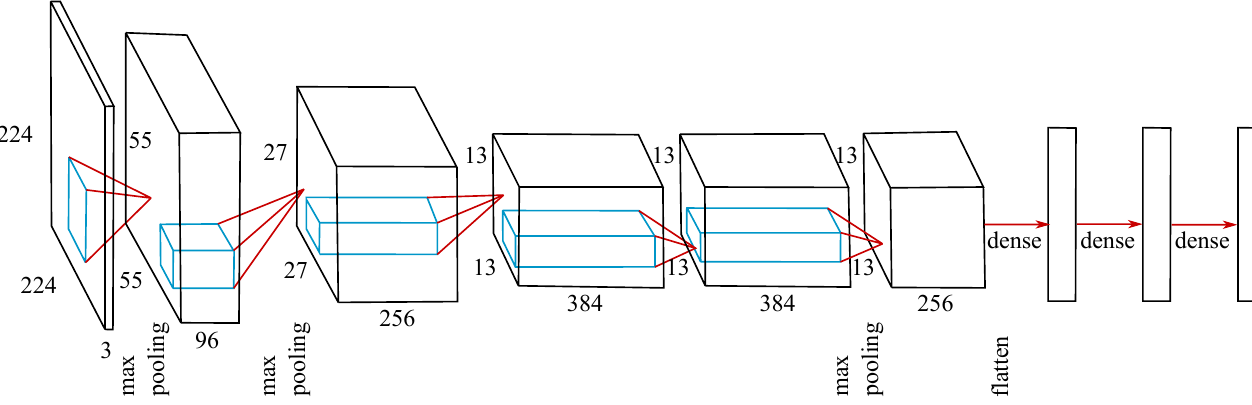
Figure 3. Architecture of the applied convolutional neural network. The size of the dense layers was found during the hyperband search and differs for the joint angle and joint moment prediction. For the pretrained model, the convolutional and pooling layers were set to be